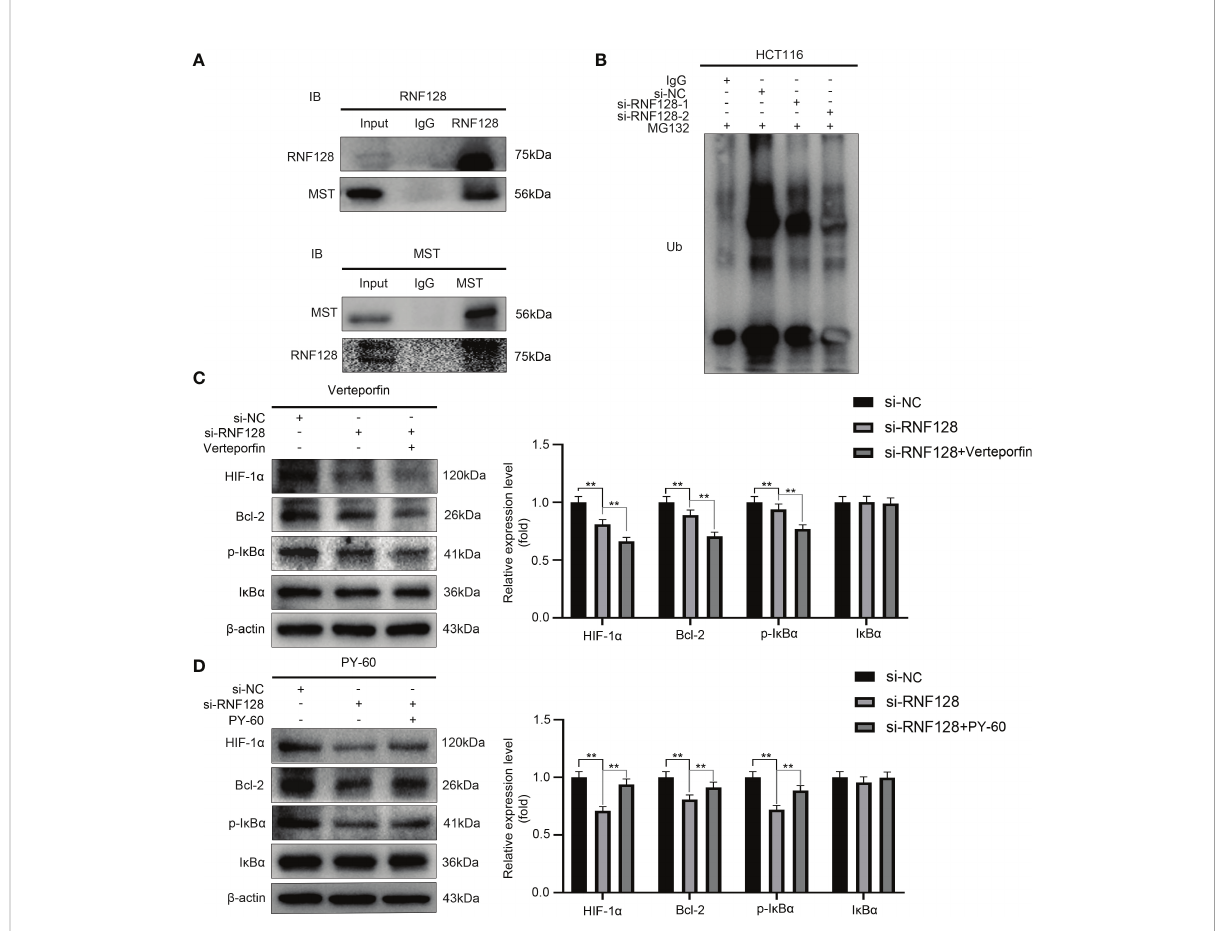
FIGURE 5 RNF128 ubiquitinates MST for degradation and regulates target genes of the Hippo signaling pathway. (A) Co-IP assays revealed that RNF128 interacts with MST. (B) An IP assay was used to examine the ubiquitination levels of MST. HCT116 cells were treated with MG132 (10 m M) for 6 h after transfection with si-NC and si-RNF128 for 48 h. (C, D) The expression levels of HIF-1 a , Bcl-2, p-I k B a and I k B a were examined by western blotting. HCT116 cells were transfected with si-NC and si-RNF128 and treated with vertepor fi n (1 m M) for 16 h and PY-60 (10 m M) for 24 h. ** P